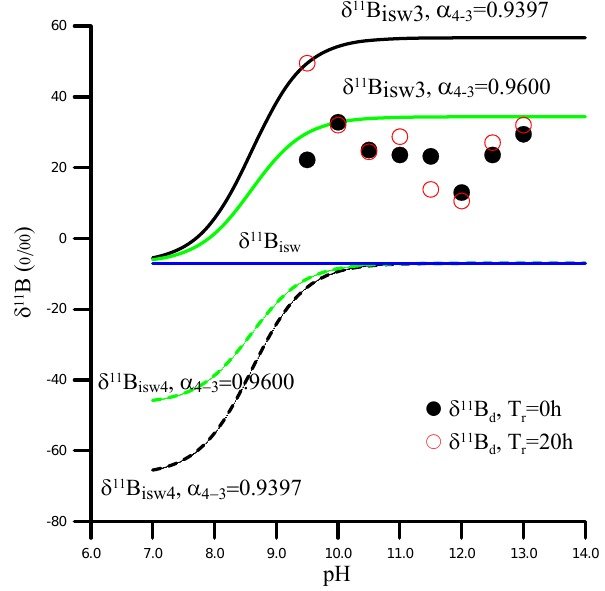
Fig. 4. δ 11 B of brucite deposit ( δ 11 B d ), and δ 11 B of B(OH) 3 ( δ 11 B isw3 ) and B(OH) 4 − ( δ 11 B isw4 ) in initial seawater calculated using different α 4 − 3 versus pH values of the parent solution. When T r =0h, the δ 11 B d values (black solid circle) are equal to or lower than the δ 11 B isw3 calculated using α 4 − 3 =0.9600 (black line). When T r =20h, the δ 11 B d values (red circle)are equal to or lower than the δ 11 B isw3 calculated using α 4 − 3 =0.9397 (green line), but all the δ 11 B d values are higher than δ 11 B isw (blue